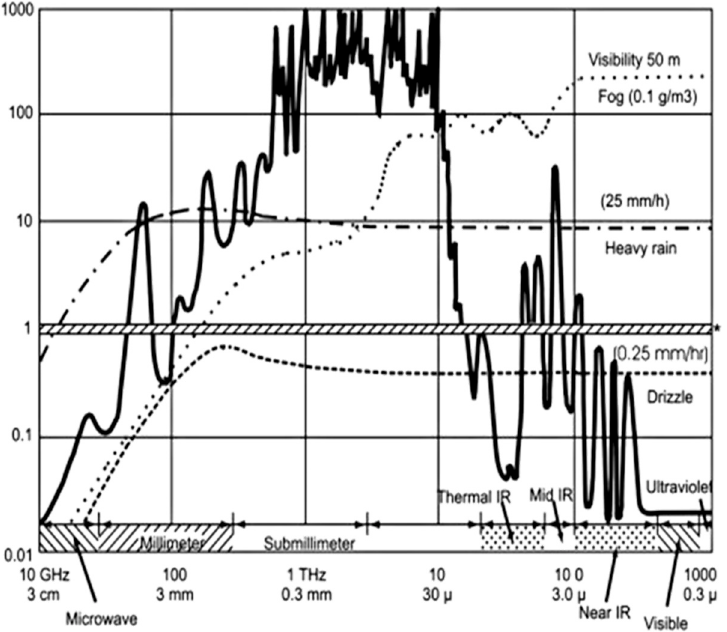
Figure 4. Radio frequency atmospheric attenuation in decibels per kilometer (on the ordinate) versus frequency and wavelength (on the abscissa).